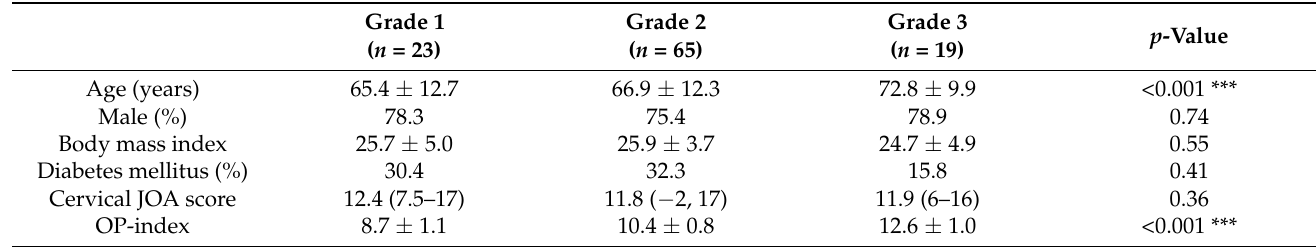
Table 2. Demographics of patients with cervical OPLL according to DISH grade.